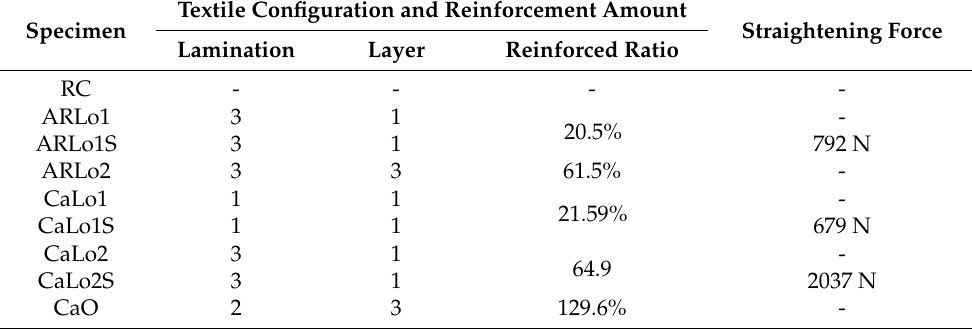
Table 4. Detailed specification of TRM beam.